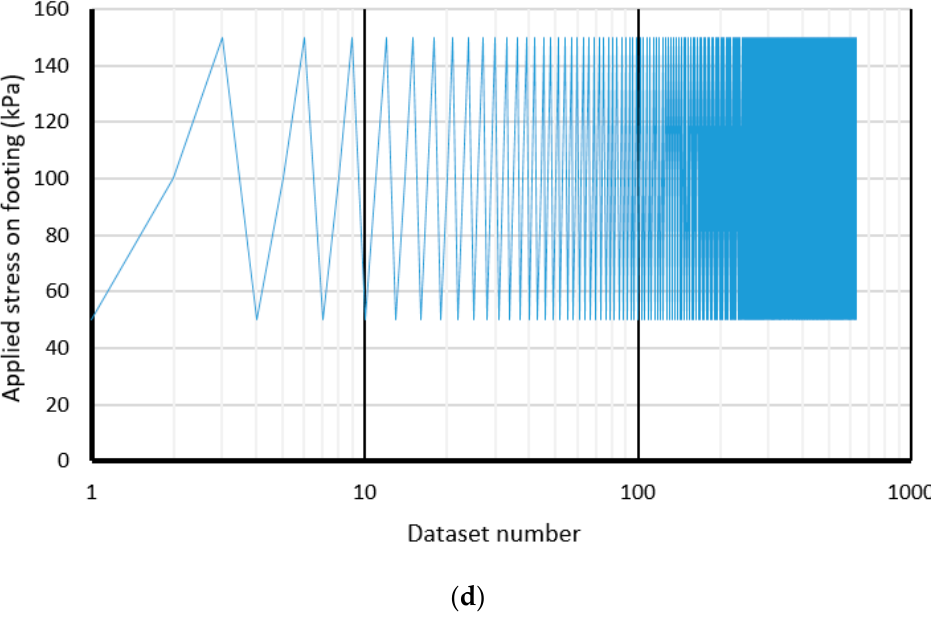
Figure 2. Graphical figure of the input information range against the numbers of data for ( a ) C u , ( b ) angle of the slope from the baseline, β , ( c ) Setback ratio (b / B), and ( d ) vertical stress on top of the slope.